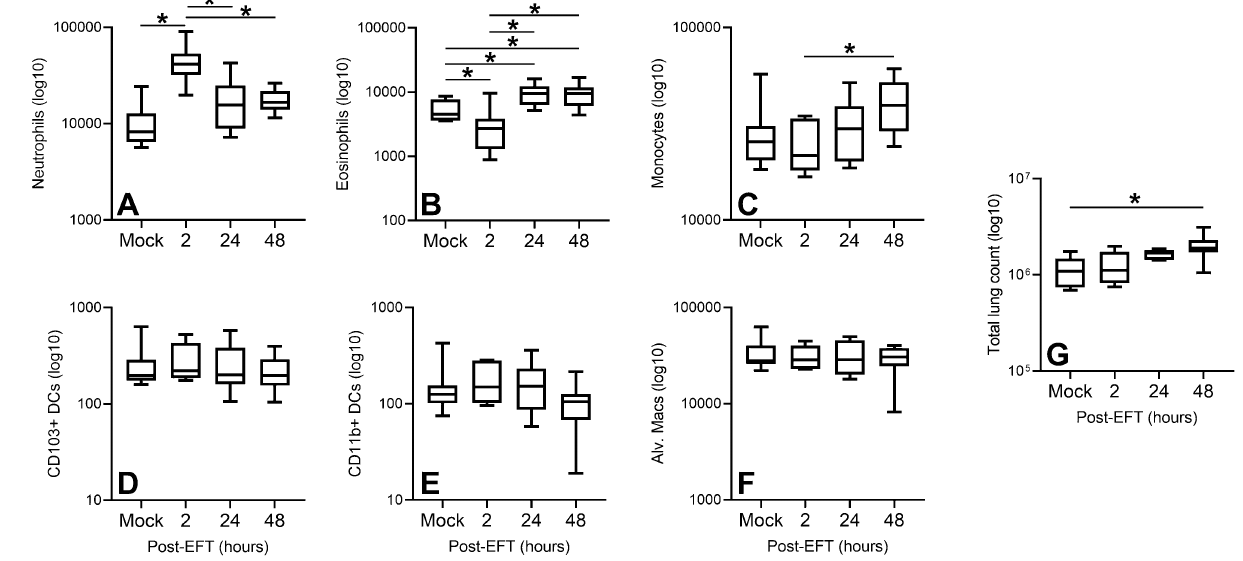
Figure 1. Lung immune cell infiltrates after EFT treatment in naïve mice. EFT (8 10 ms pulses at 200 V/cm) or mock control was administered to naive mice and mice were sacrificed at 2, 24, and 48 h post-EFT for lung cellular analysis by flow cytometry. Cell counts per lung for ( A ) neutrophils, ( B ) eosinophils, ( C ) monocytes, ( D ) CD103 + dendritic cells, ( E ) CD11b + dendritic cells, and ( F ) alveolar macrophages are shown. G) Total lung cell counts. Data are from two independent experiments, n = 7–10 for each group at each time point. Boxes are median line with first and third quartiles, min/max shown with brackets. * p < 0.05 by